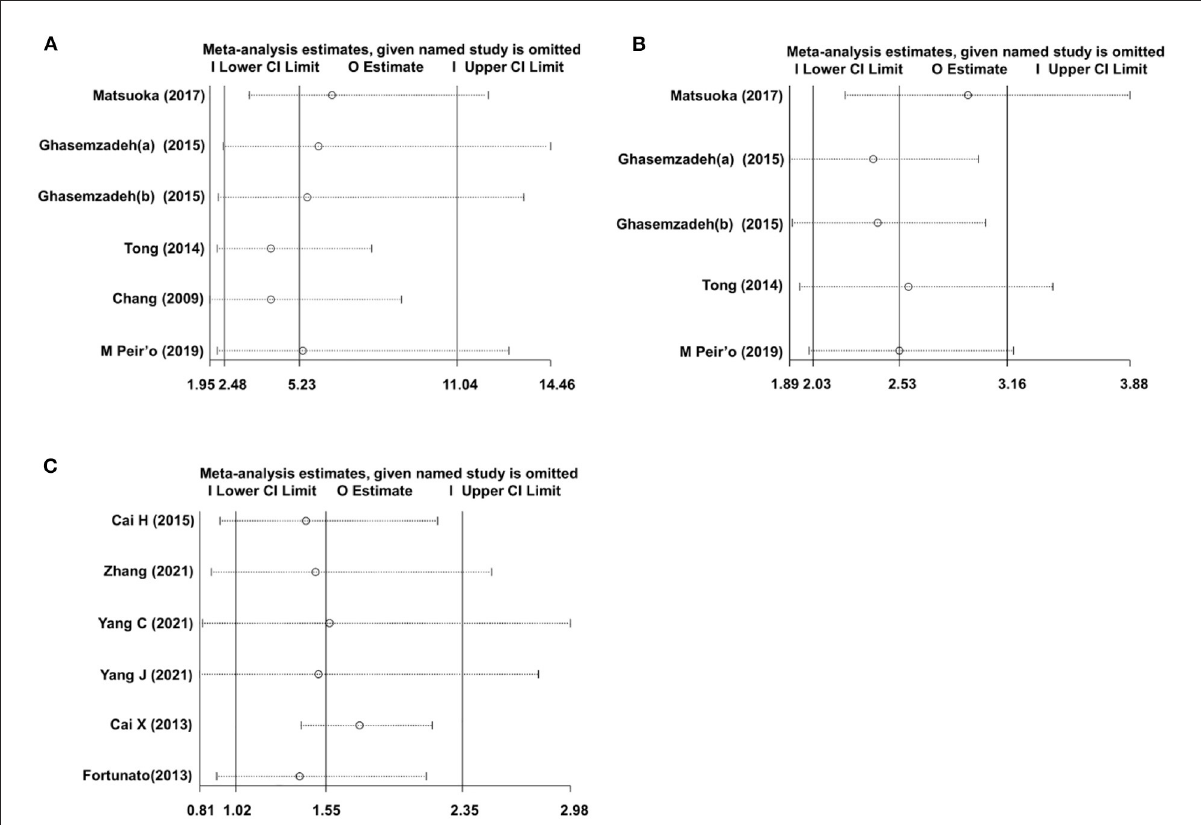
FIGURE6 Sensitivity analysis evaluating the influence of any single study on the overall effects. (A) Univariate analysis data of the CXCL12 level as category variable group. (B) Multivariate analysis data of the CXCL12 level as category variable group; (C) Multivariate analysis data of the CXCL12 level as the continuous variable